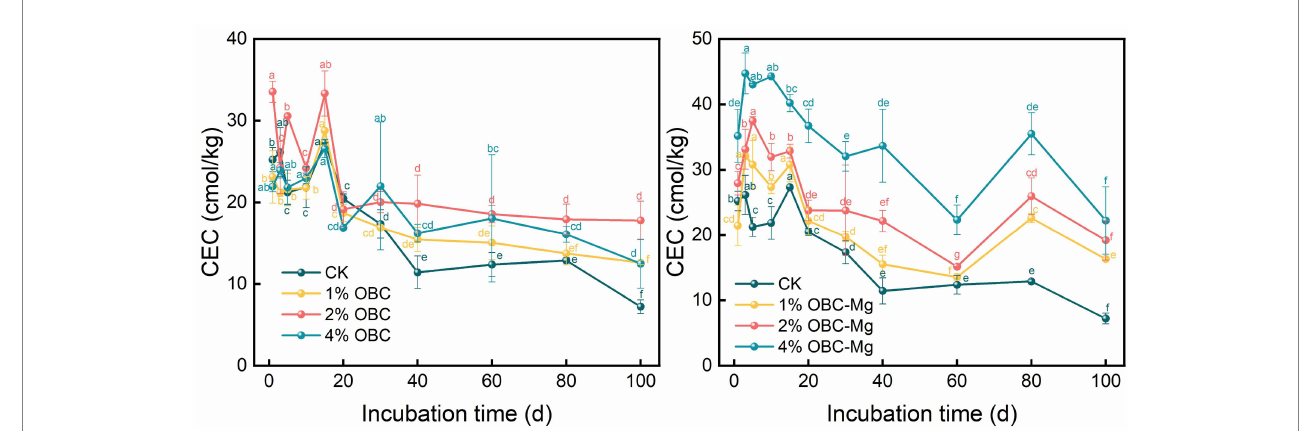
FIGURE. 3 Changes in soil cation exchange capacity (CEC) after the amendment of OBC and OBC-Mg.